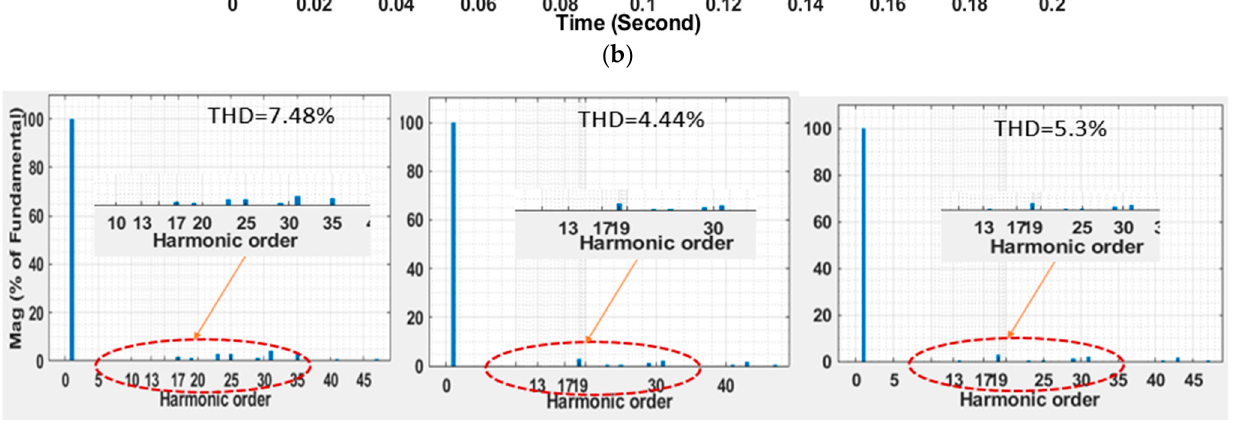
Figure 9. Fitness value for MPA versus modulation index.